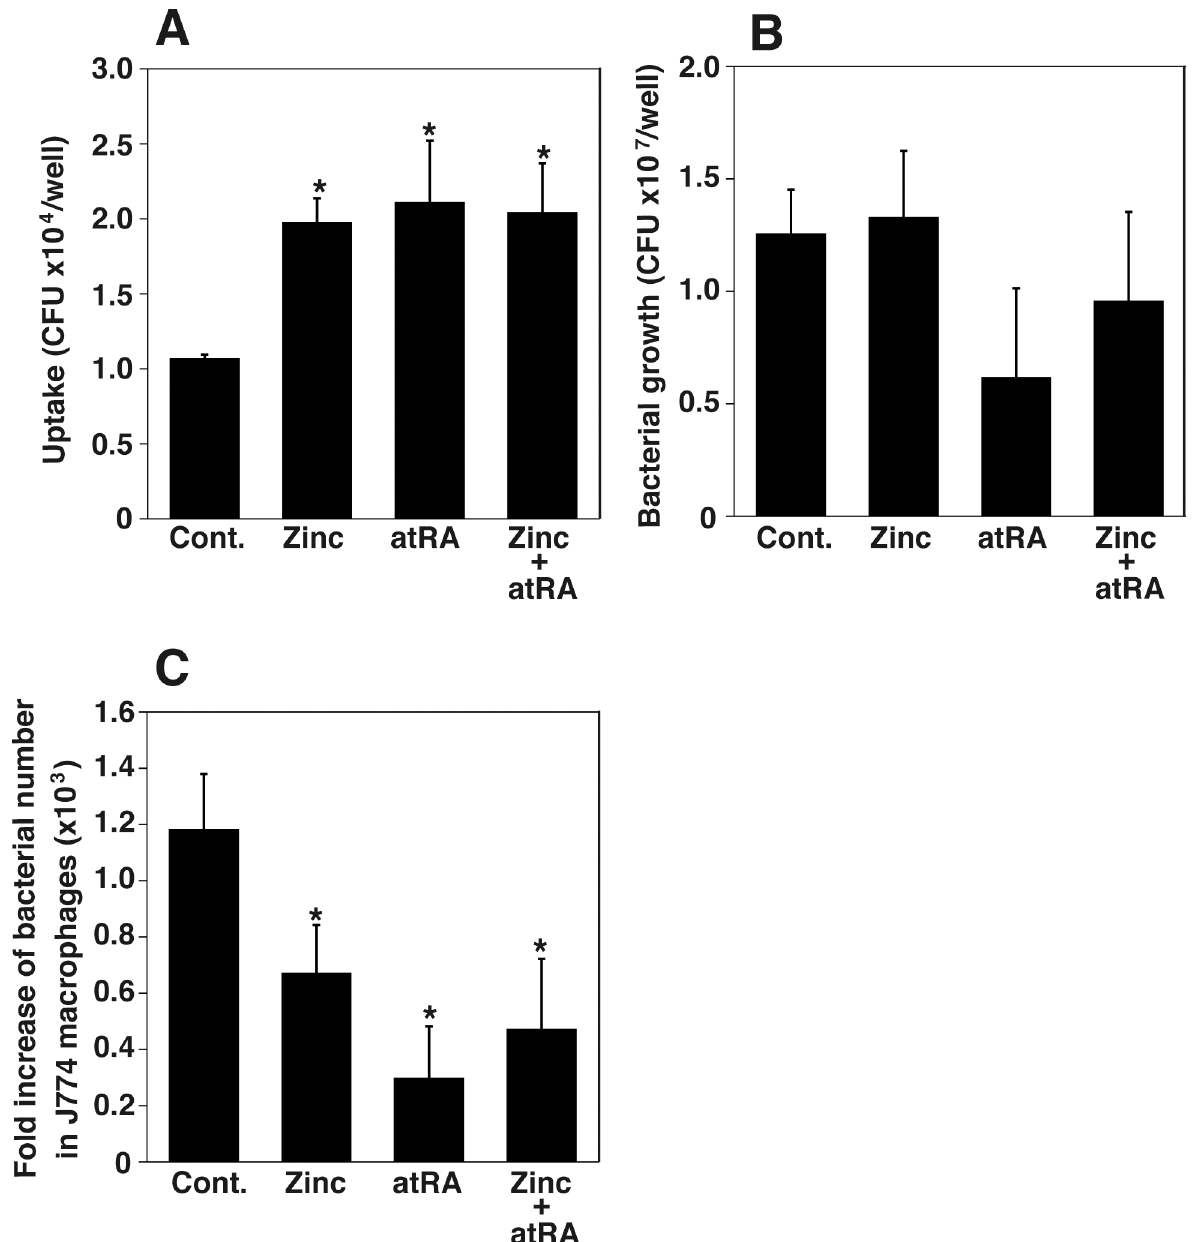
Fig 4. L . monocytogenes macrophage uptake and bacterial survival after Zn and atRA supplementation. J774 macrophage cells were infected with L . monocytogenes by centrifugation at 150 × g for 10 min at room temperature at a multiplicity of infection of 0.1. Bacterial uptake (A) was measured after 30 min of incubation at 37°C and bacterial survival (B) was measured after 24 h. ZnSO 4 (40 μ M) or atRA (20 μ M) were added 48 h before infection. Panel C shows fold increase of bacterial number in macrophages. Results are presented as fold increase of bacterial number relative to the number of phagocytosed bacteria. Data are the averages of triplicate samples from three identical experiments and error bars represent SD. Statistically significant differences, compared with the control, are indicated by asterisks.